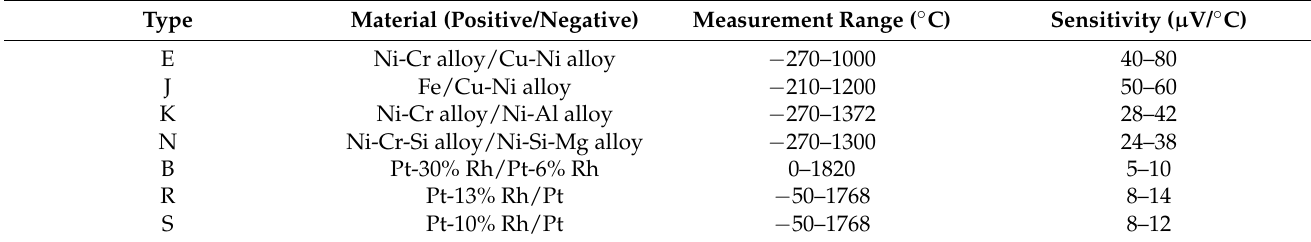
Table 1. A summary of thermocouple properties commonly used in combustion environments